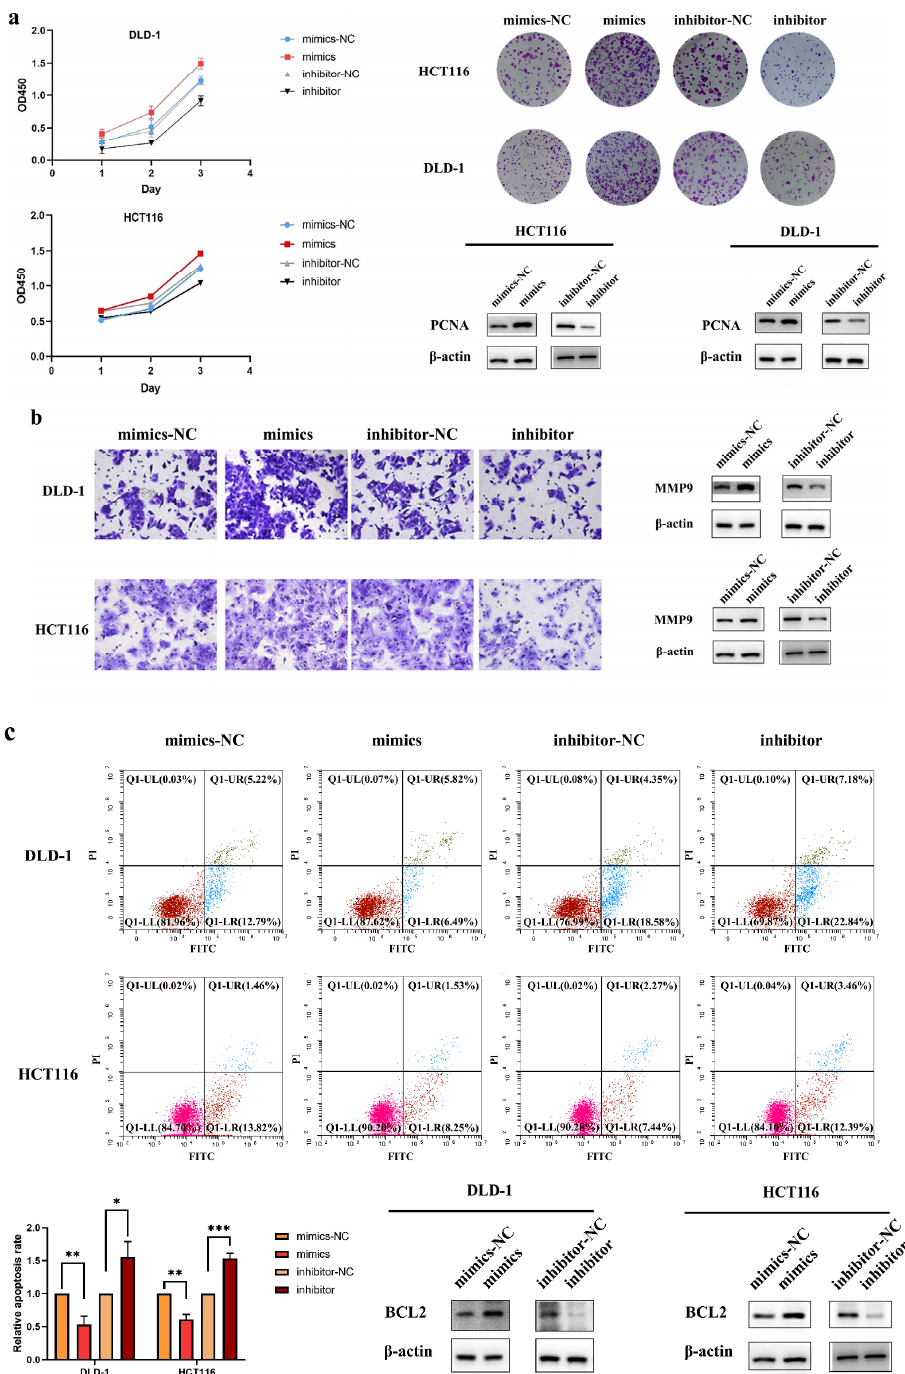
Figure 2. The assays of cell proliferation, transwell and apoptosis on DLD ‐ 1 and HCT116. ( a ) The cell proliferation curves, colony formation assays and PCNA expression level, the values of OD450 are expressed as mean ± SD, the pictures of colony formation were taken by a smartphone, the diameter of the well is about 34.8 mm; ( b ) the transwell assays and MMP9 expression level, the pictures of transwell were taken by a 20× objective and a 10× eyepiece; ( c ) the cell apoptosis assays and BCL2 expression level. All assays contained mimics, mimics ‐ NC, inhibitor, inhibitor ‐ NC group. The relative apoptosis rate is expressed as mean ± SD, * p < 0.05, ** p < 0.01, *** p < 0.001. Each assay was performed in triplicate.